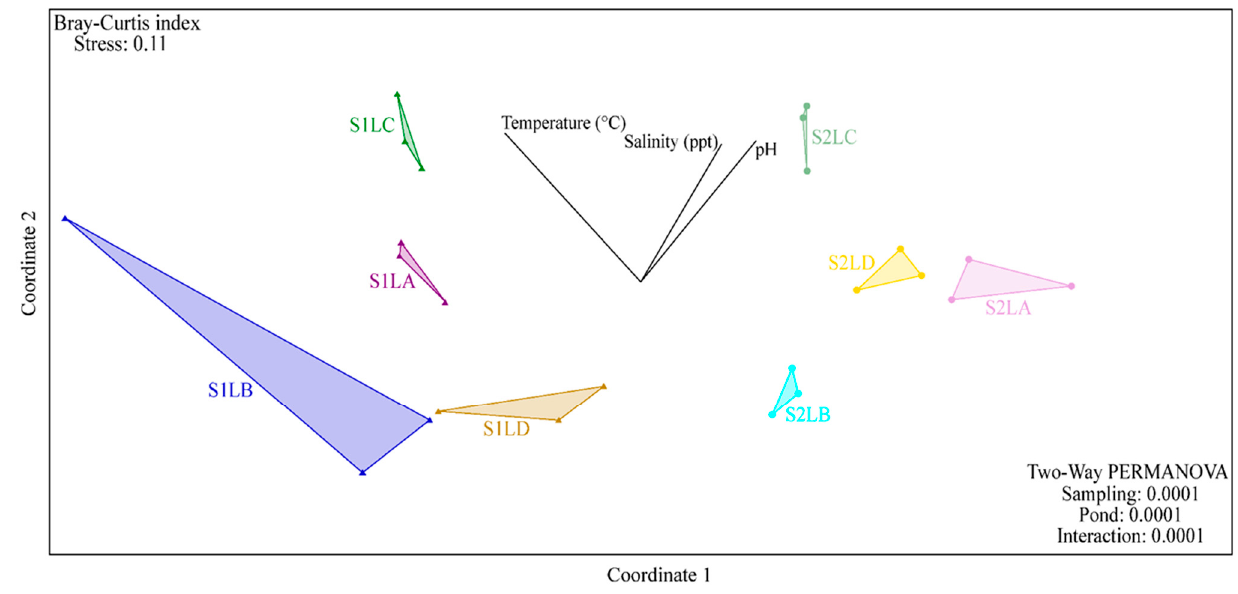
Figure 3. Nonmetric multidimensional scaling (nMDS) with the Bray–Curtis dissimilarity index. Representation of LA (purple), LB (blue), LC (green) and LD (yellow). The replicates are represented by triangles in dark tones (S1) and circles in light tones (S2). The physical–chemical data evaluated from the water samples from the ponds were integrated as